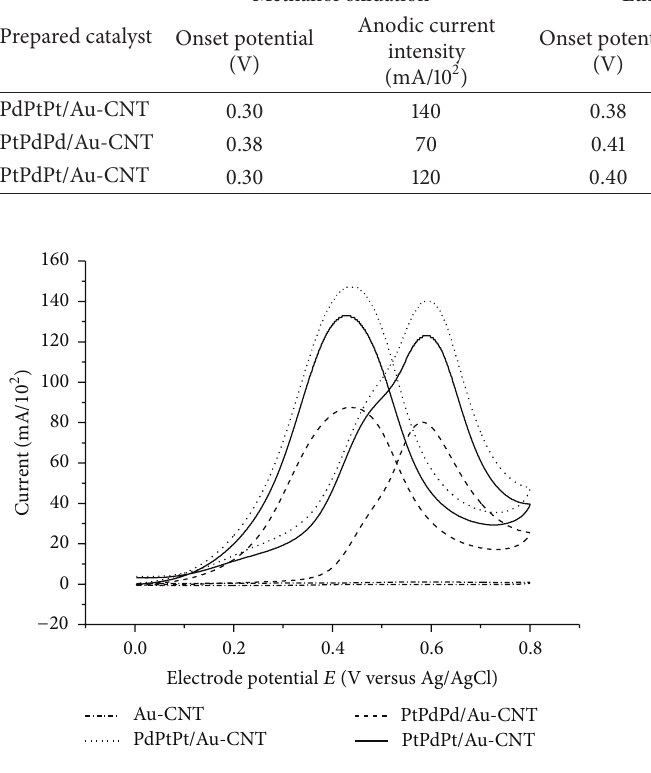
Figure 3: Cyclic voltammograms recorded in 2MCH 3 CH 2 OH + 1MH 2 SO 4 solution at Au-CNT, PdPtPt/Au-CNT, PtPdPd/Au-CNT, and PtPdPt/Au-CNT in the potential range 0.00 to 0.80 V at a scan rate 0.05 V ⋅ s −1